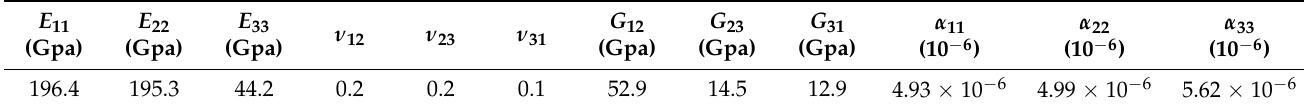
Table 5. Equivalent thermoelastic parameters.